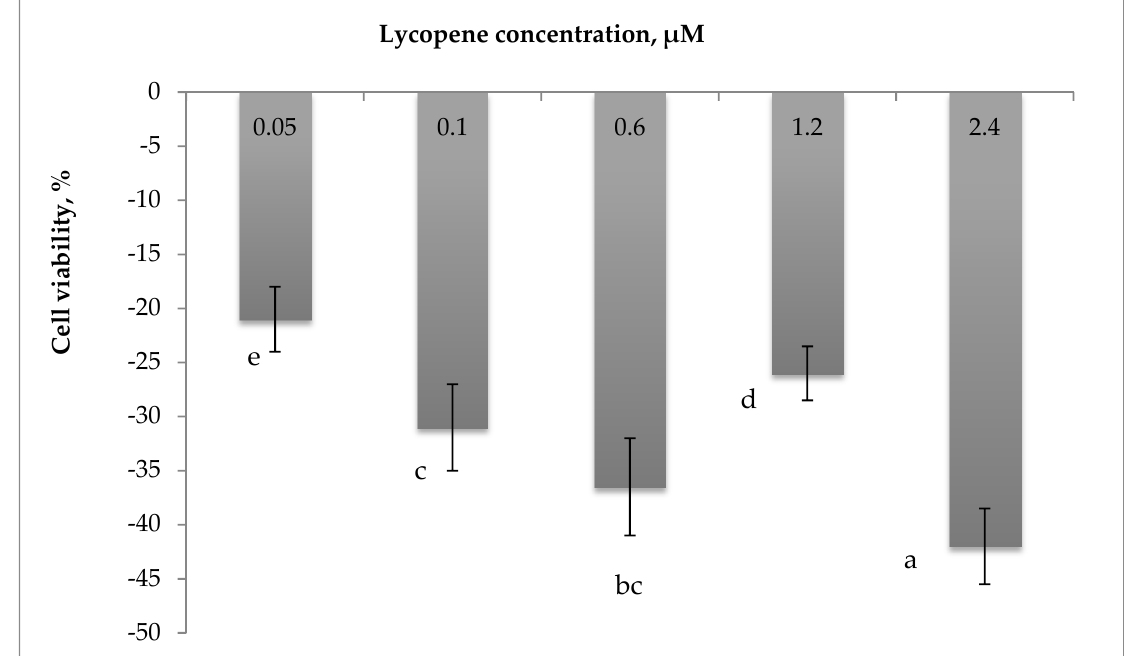
Figure 4. The effects of different concentrations of lycopene on rat glioblastoma cells. To evaluate the effect of lycopene on the generation of intracellular ROS in glioblastoma cells, the cells were treated with different concentrations of lycopene (0.05– 2.4 µM). It was determined that lycopene promotes ROS burst in glioblastoma cells by 12, 22, 34, and 42% (Figure 5).